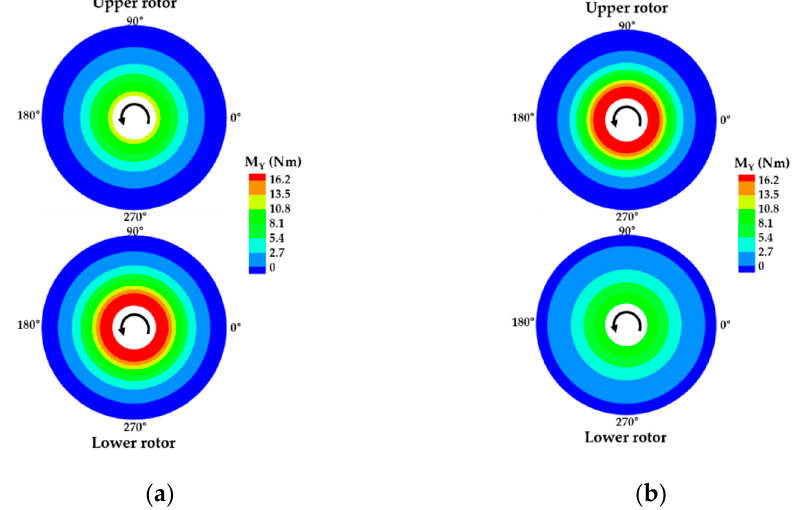
Figure 15. Flap bending moment (M Y ) distributions at the axial spacing of 5.27%R ( C T = 0.0102): ( a ) Index angle = − 10 ◦ ; ( b ) index angle = 10 ◦